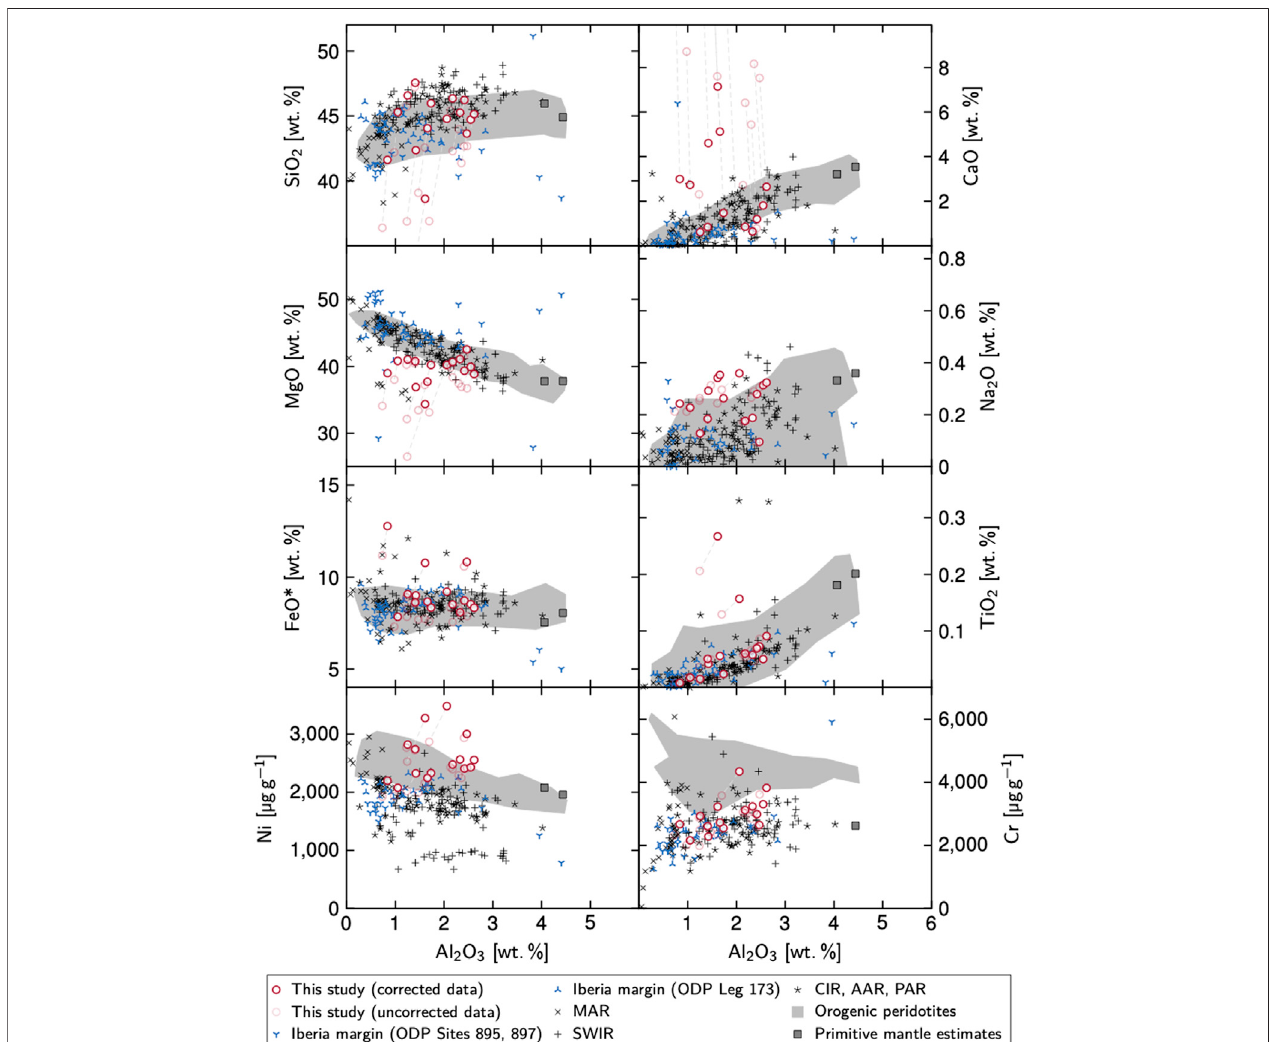
FIGURE 3 | Bulk rock geochemical compositions of the Hole 637A serpentinites. Shown are data before and after the correction for late-stage CaCO 3 metasomatism; dashed lines connect corrected (red circles) with uncorrected compositions (transparent red circles). For comparison, bulk compositions from other Iberia margin rocks (Seifert and Brunotte, 1996; Hébert et al., 2001), MOR sites (Seyler et al., 2003; Kelemen et al., 2004; Niu, 2004; Godard et al., 2008; Jöns et al., 2010), tectonically emplaced “ orogenic ” peridotites (Bodinier and Godard, 2014), and of primitive mantle estimates (Hofmann, 1988; McDonough and Sun, 1995) are shown. Abbreviations: AAR, American – Antarctic Ridge; CIR, Central Indian Ridge; MAR, Mid-Atlantic Ridge; PAR, Paci fi c – Antarctic Ridge; SWIR, Southwest Indian Ridge.